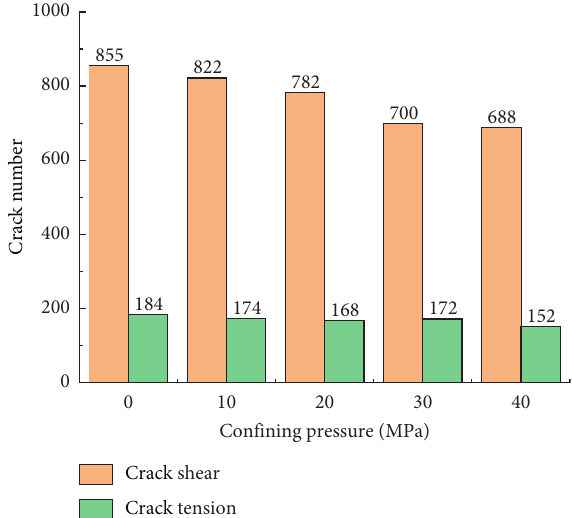
Figure 7: Statistics of the number of cracks under different disc cutter spacing.